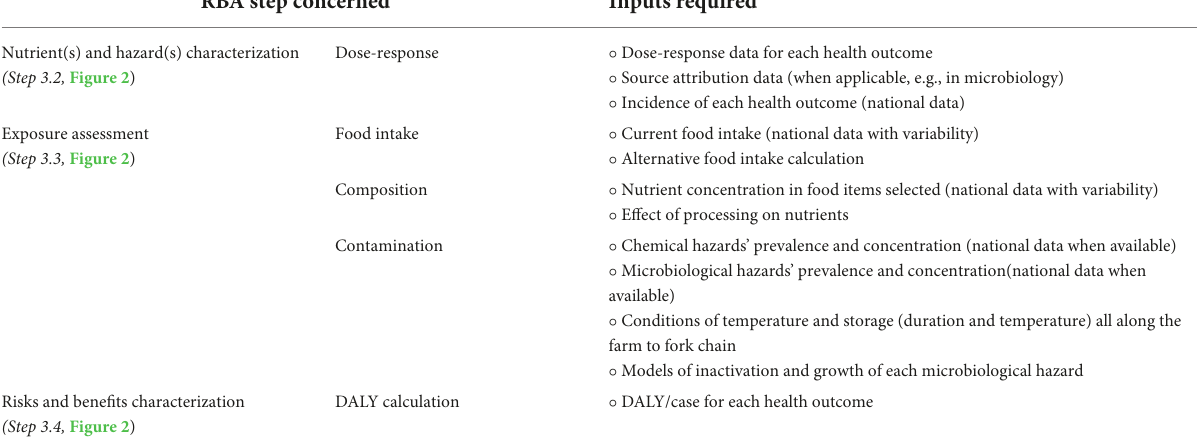
TABLE 1 List of data required for feasibility of the NovRBA case study. RBA step concerned Inputs required Nutrient(s) and hazard(s) characterization (Step 3.2, Figure 2 )